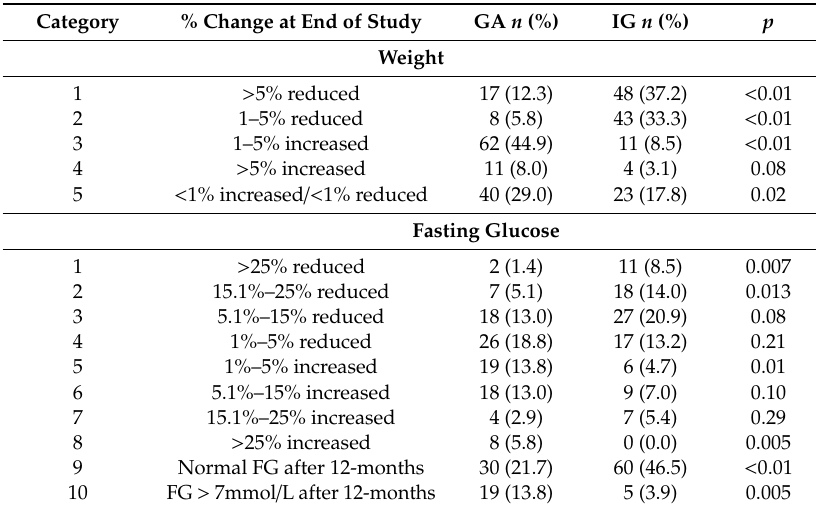
Table 4. Percentage change in primary endpoints according to